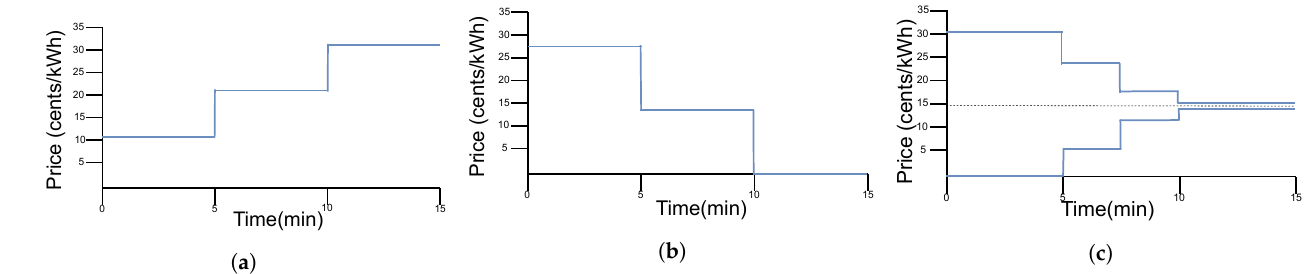
Figure 2. Trading strategy for ( a ) Load, ( b ) PV, and ( c ) battery